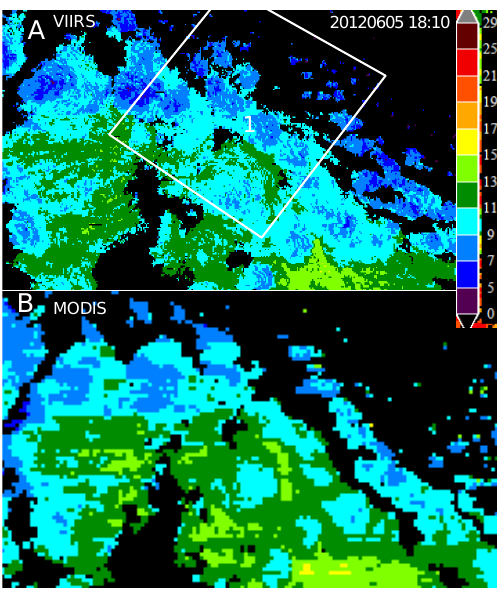
Fig. 11. VIIRS and MODIS retrieved r e for the clouds shown in Fig. 10. Only clouds with 0.6µm solar reflectance >0.4 are ana-